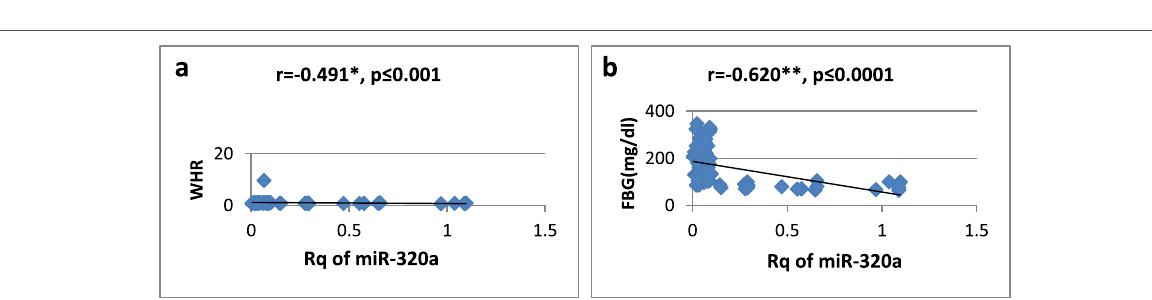
0.491), where “*” means significant at p = −